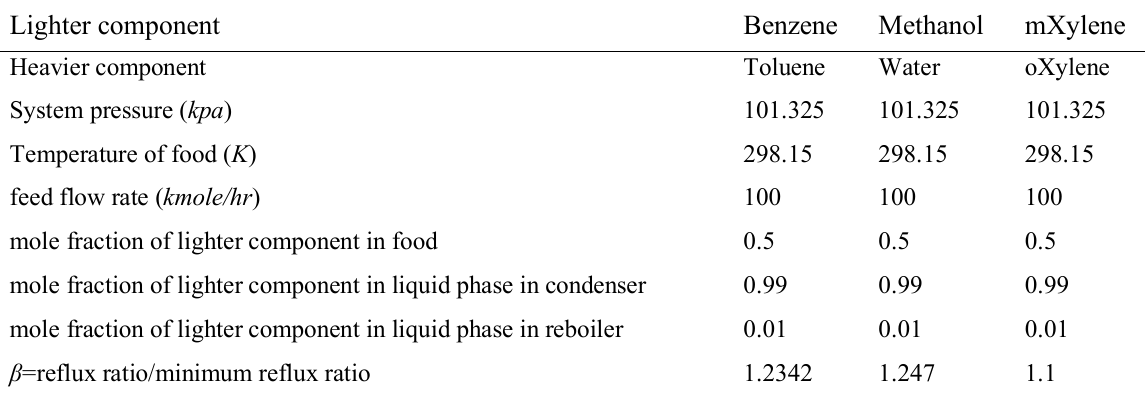
Table 1. Operating conditions of distillation